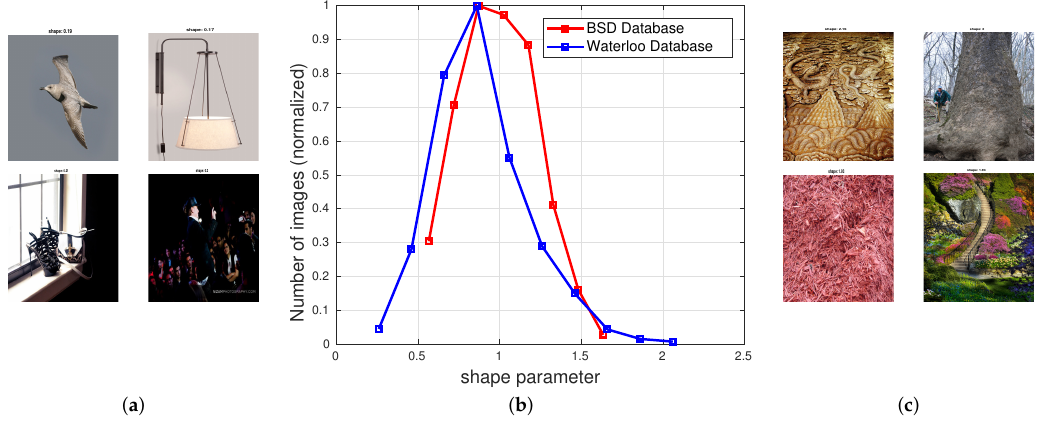
Figure 4. Empirical distribution ( b ) of the estimated shape parameter s obtained by fitting the joint MSGCN coefficients of pristine images from the Waterloo exploration and the Berkeley Segmentation Database (BSD) database with an multivariate generalized Gaussian (MVGG). Images yielding values of s at extremities of the distribution ( s ≤ 0.2 and s > 2.0) are shown in ( a ) and ( c ),